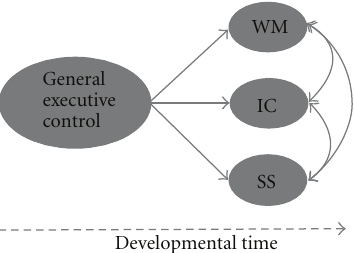
Figure 1: A simplified model showing a unitary executive function (EF) construct early in development and an emergent fractionated construct of EF with development with latent EF variables of working memory (WM), inhibitory control (IC), and set-shifting